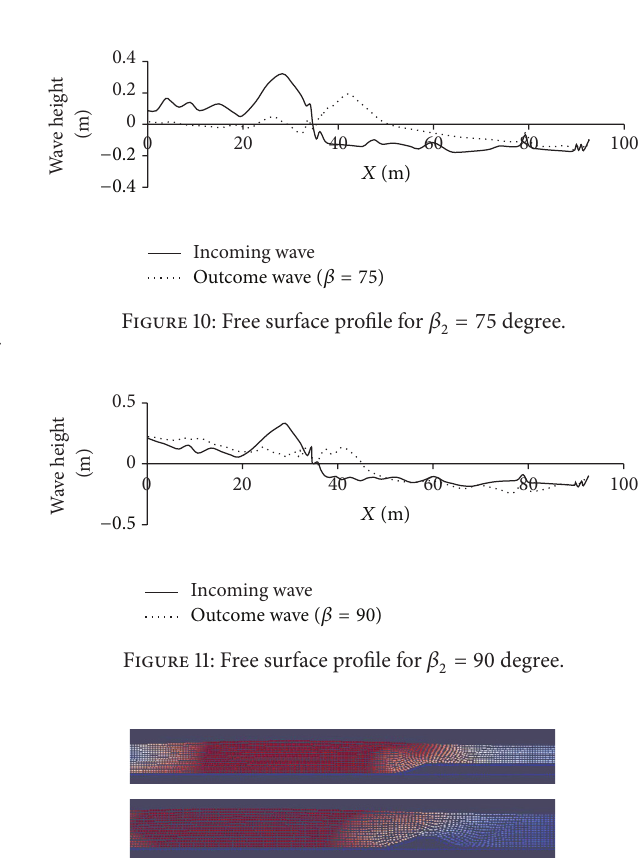
Figure 12: A representative frame of SPH